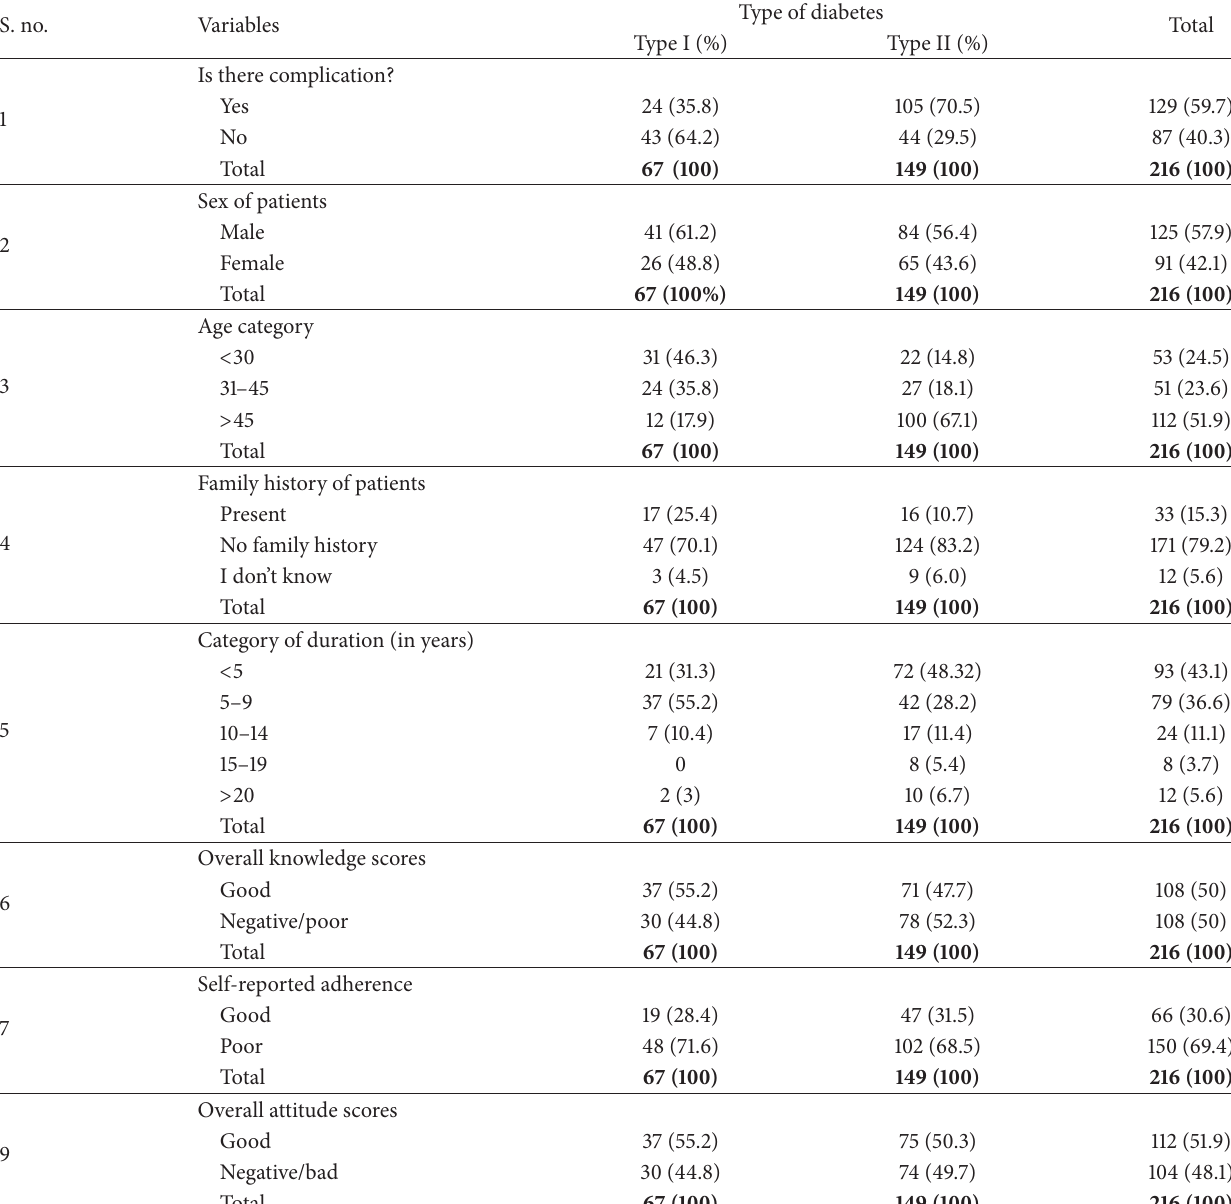
Table 3: Distribution of variables based on the type of diabetes in Dessie Referral Hospital, 2013 ( 𝑛 = 216 ). S.